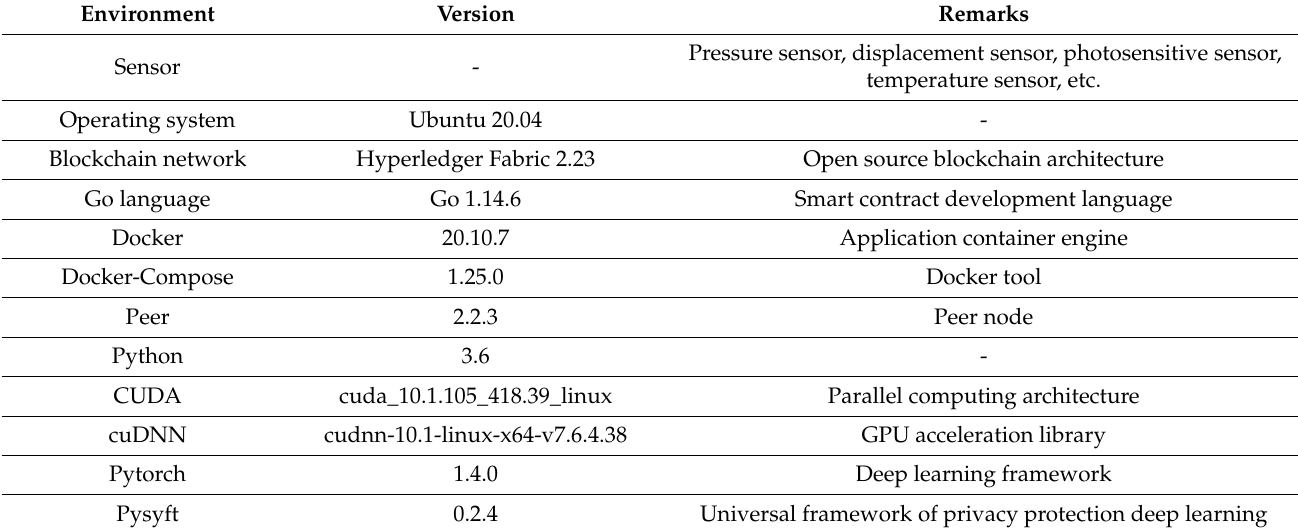
Table 2. Experimental configuration table.